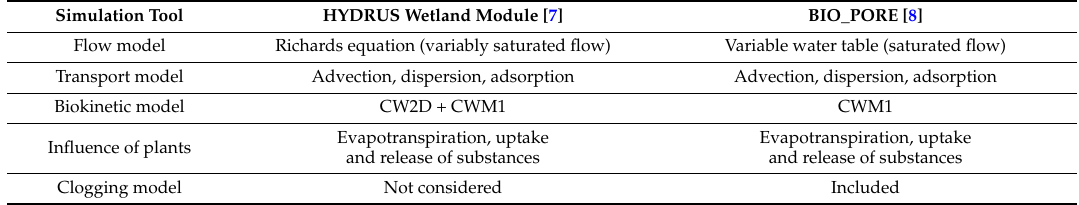
Table 2. Comparison of implemented sub-models in the HYDRUS Wetland Module and BIO_PORE (adapted from